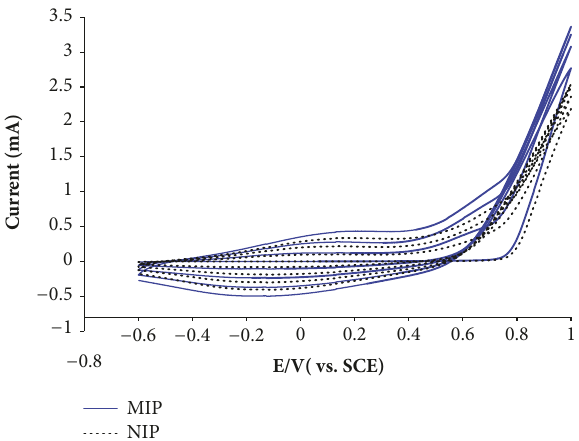
Figure 1: Cyclic voltammograms recorded during the formation of the imprinted and nonimprinted polypyrrole films at glassy carbon electrode. Experimental conditions: [pyrrole] = 0.1 M; [ETP] = 3.0 × 10 −4 M; [NaClO 4 ] = 0.1 M; number of cyclic scans = 4; scan rate = 100 mVs −1